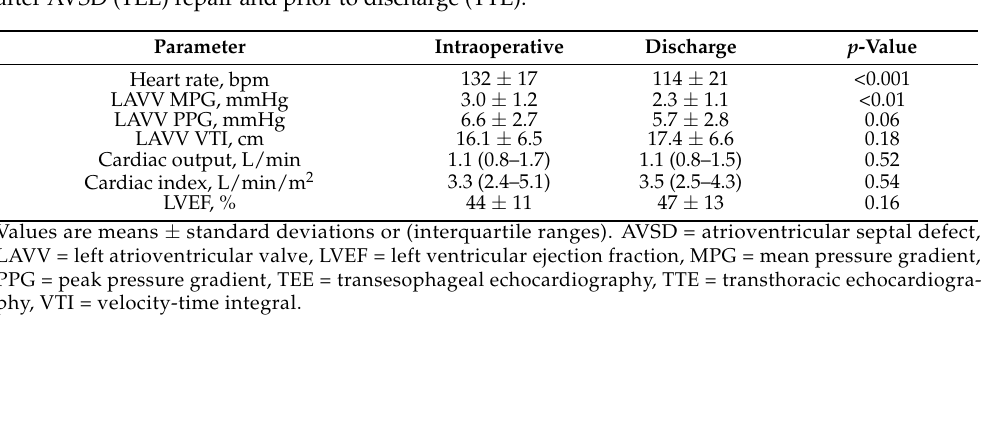
Table 3. Results of the echocardiographic measurements performed intraoperatively immediately after AVSD (TEE) repair and prior to discharge